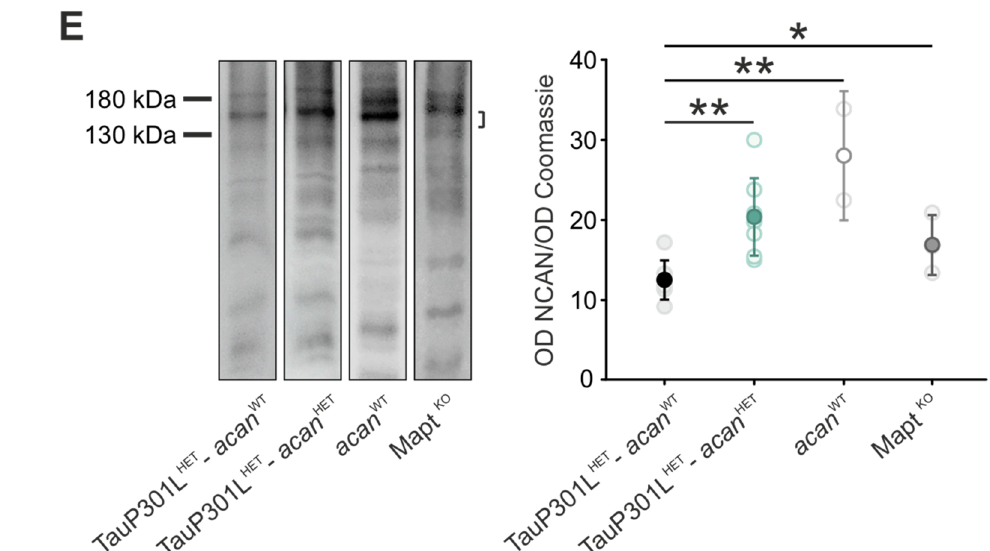
Figure 2. Characterization of neurocan in the Mo5 of TauP301L- acan mice. ( A – D ) Immunohistochem- ical analysis of neurocan (NCAN, AF5800 (R&D Systems)) in the motor trigeminal nucleus (Mo5) of 3 TauP301L HET - acan WT ( A , B ) and 3 TauP301L HET - acan HET mice ( C , D ). High magnification confocal images ( B , D ) of neurocan immunoreaction visualize location and structure of the immunoreaction. Location and structure of the neurocan immunoreaction did not reveal any genotype-specific differ- ences ( A , C ). Neurocan immunoreaction was exclusively detected extracellularly ( B , D ). ( E ) Western blot analysis of neurocan protein level (AF5800 (R&D Systems), at ~150 kDa) in the brainstem with a significant increase in TauP301L HET - acan HET mice compared to TauP301L HET - acan WT mice ( p = 0.001, TauP301L HET - acan WT n = 7, TauP301L HET - acan HET n = 8, t -test). Neurocan protein level was signifi- cantly increased in acan WT mice compared to TauP301L HET - acan WT mice ( p = 0.001, TauP301L HET - acan WT n = 7, acan WT n = 2, t -test). Mapt KO mice revealed a significantly increased neurocan protein amount compared to TauP301L HET - acan WT mice ( p = 0.049, TauP301L HET - acan WT n = 7, Mapt KO n = 3, t -test). For Western blot analysis protein extracts from homogenized brainstems of 7 TauP301L HET - acan WT , 8 TauP301L HET - acan HET , 2 acan WT , and 3 Mapt KO mice were used. Optical density (OD) of the specific chemoluminescence signal was quantified in relation to Coomassie stained total protein bands. Quantified areas on the Western blot lanes were marked by a bracket. For illustration of exemplary blot lanes, brightness and contrast were adapted. Data are given as mean ± SD, * p < 0.05, ** p < 0.01. Scale bar in ( A , C ) 50 µ m, in ( B , D ) 10 µ m.